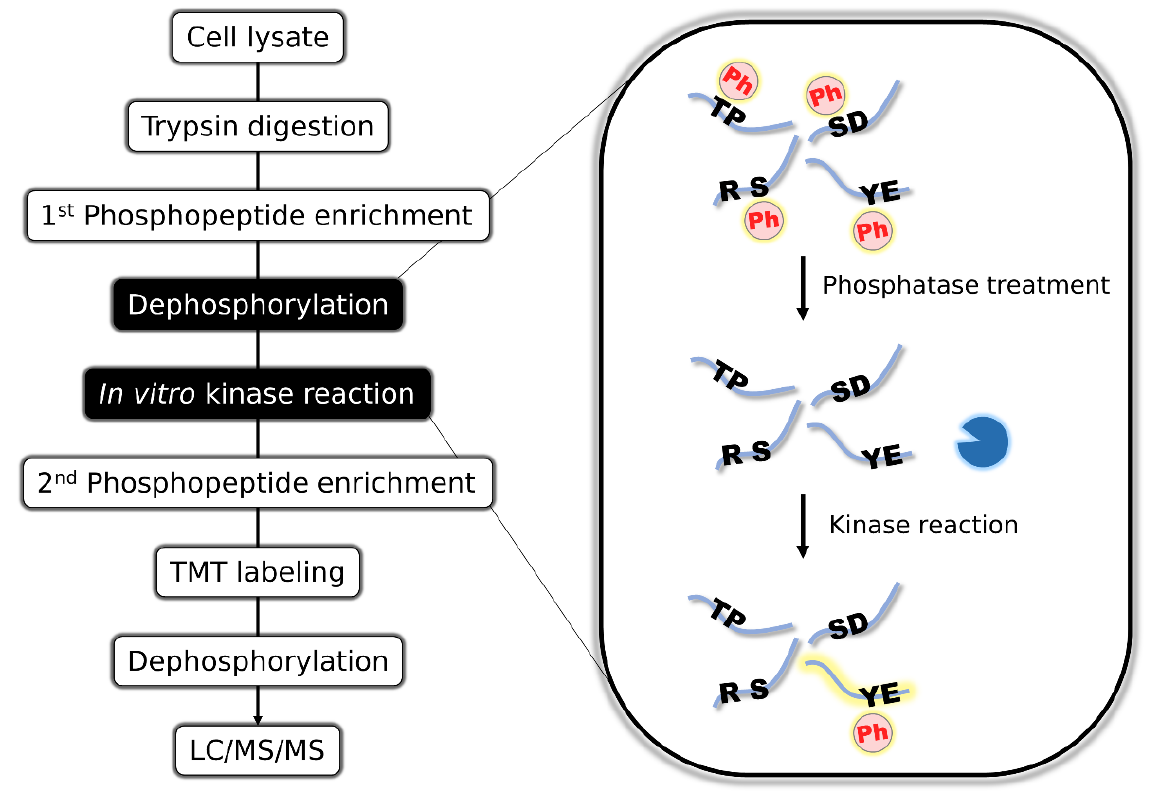
Figure 1. Schematic representation of the motif-targeting workflow. Phosphopeptides are first enriched from cell lysates by TiO 2 metal oxide chromatography. Enriched phosphopeptides are completely dephosphorylated by the addition of alkaline phosphatase, followed by in vitro kinase reaction to phosphorylate the peptides with specific primary sequence motifs. The derived phospho- peptides are enriched again, TMT-labeled, dephosphorylated to enhance the MS detectability, and analyzed by